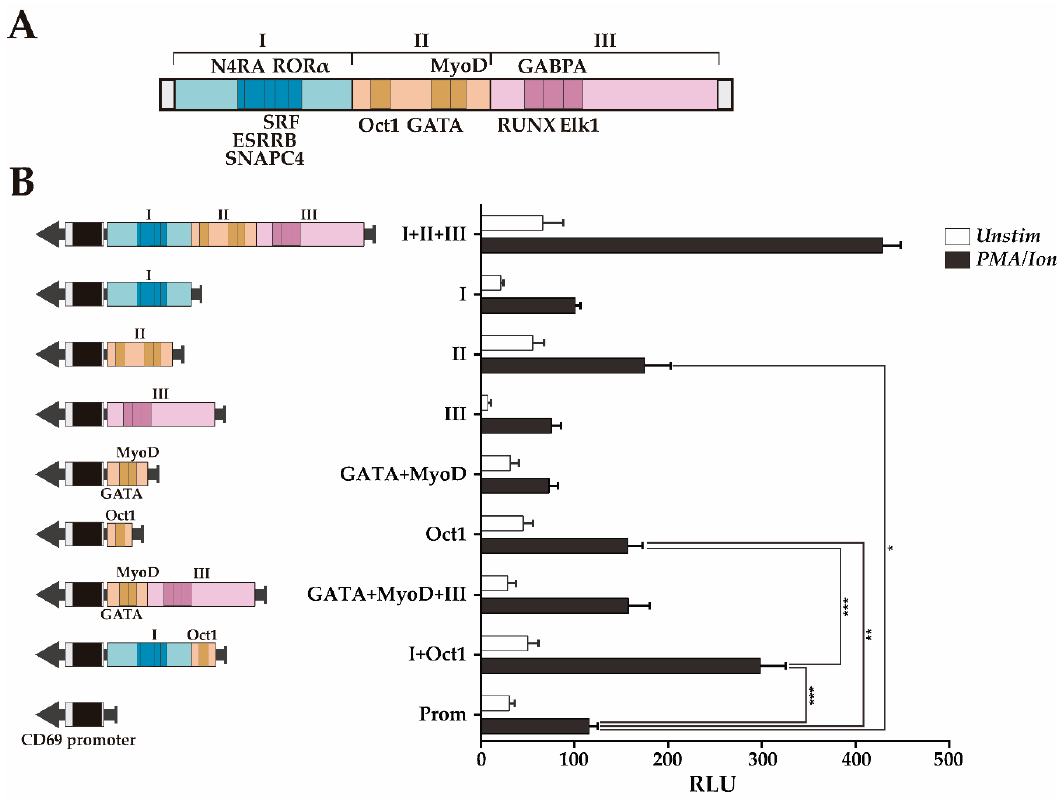
Figure 4. Transcriptional enhancer activity of the CNS2 regions I+II+III and region II subregions. 206 (A) Map of regions I-III and the conserved TFBSs within them. (B) Measurement of the luciferase 207 or in combination with the di ff erent regions and subregions (I + II + III, I, II, II, GATA + MyoD, OctI, activity after stimulation of Jurkat cells transfected with constructs carrying the mouse CD69 208 GATA + MyoD + III, Oct1 + I). The bars show the mean RLU. The error bars show the standard deviation promoter alone or in combination with the different regions and subregions (I+II+III, I, II, II, 209 of three independent experiments with duplicate measurements. One factor ANOVA was applied GATA+MyoD, OctI, GATA+MyoD+III, Oct1+I). The bars show the mean RLU. The error bars show 210 to test for significant di ff erences, with * ( p < 0.05), ** ( p < 0.01), and *** ( p < 0.001). RLU: Relative the standard deviation of three independent experiments with duplicate measurements. One factor 211 luciferase ANOVA was applied to test for significant differences, with * ( p < 0.05), ** ( p < 0.01), and *** ( p < 212 0.001). RLU: Relative luciferase units. 213